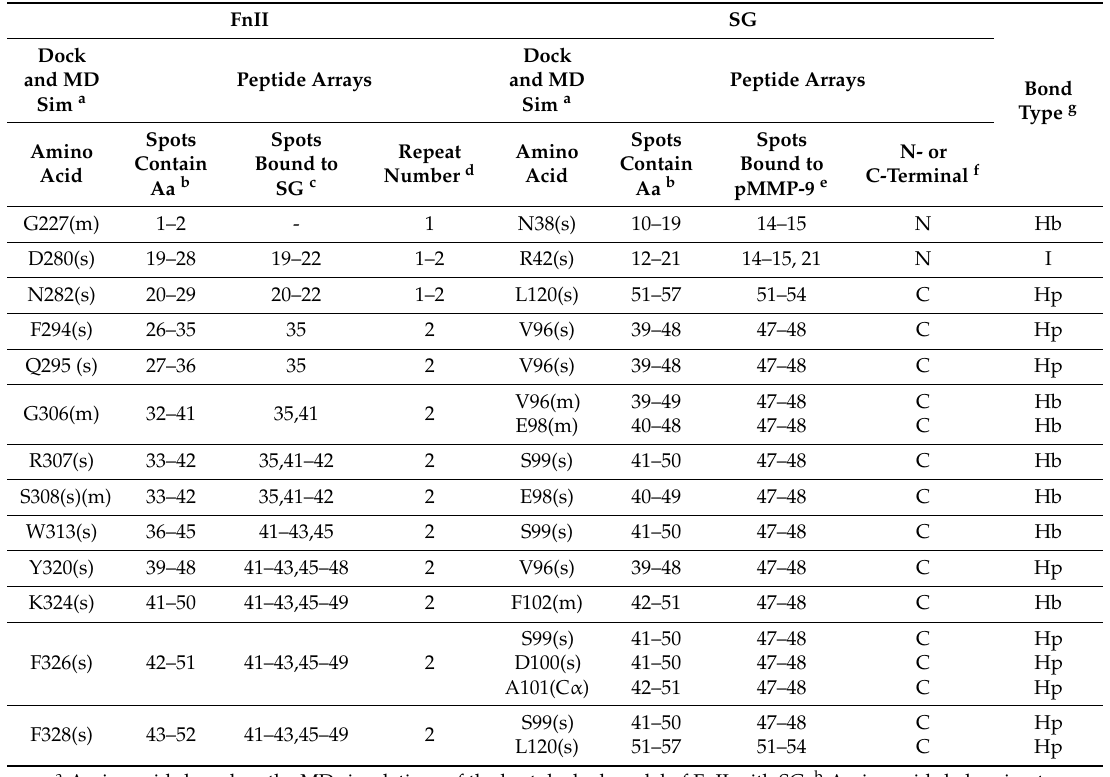
Table 1. Amino acid interactions between FnII and SG. Amino acid interactions between FnII and SG based on peptide arrays, docking, and MD